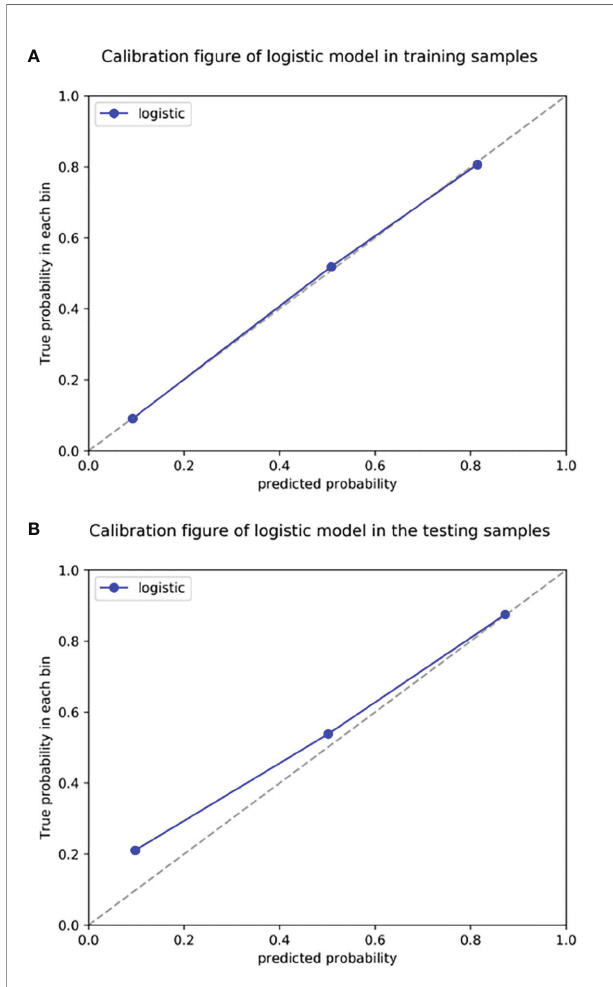
FIGURE 7 | Radiomics nomogram calibration curves for the training (A) and testing (B) sets. The calibration curves show a good fi t of the nomogram. The 45° straight lines indicate a perfect match between the true (Y-axis) and predicted (X-axis) probabilities. The closer the distance between the two curves, the better the accuracy.